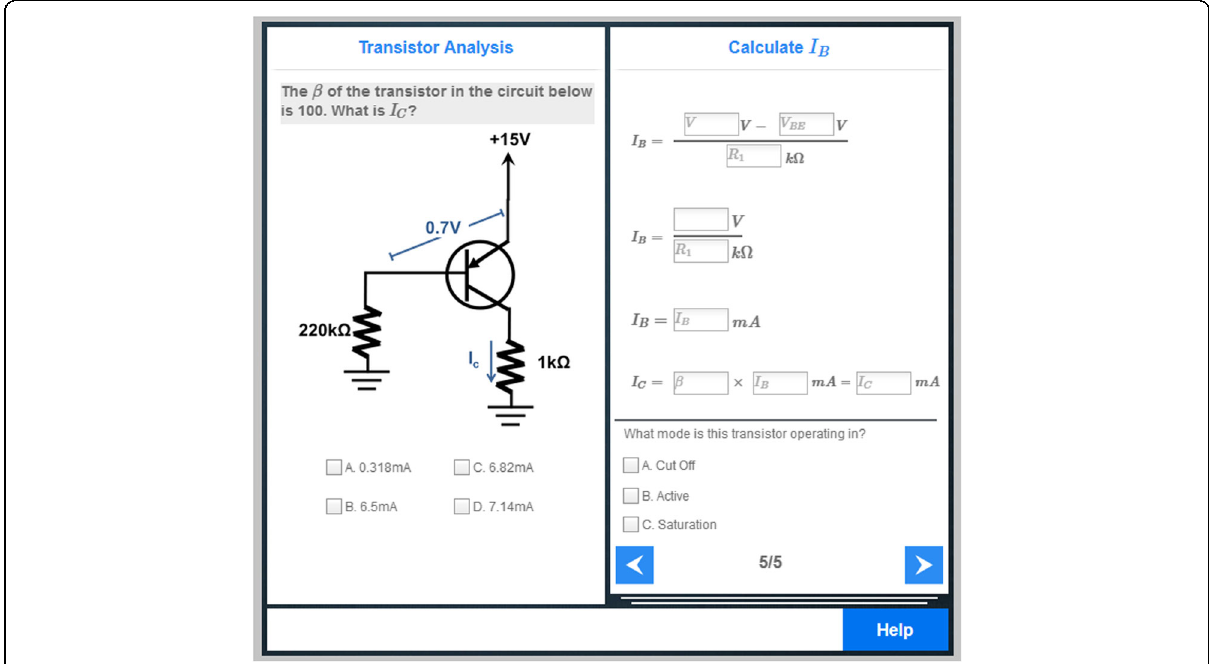
Fig. 8 A problem-solving task on